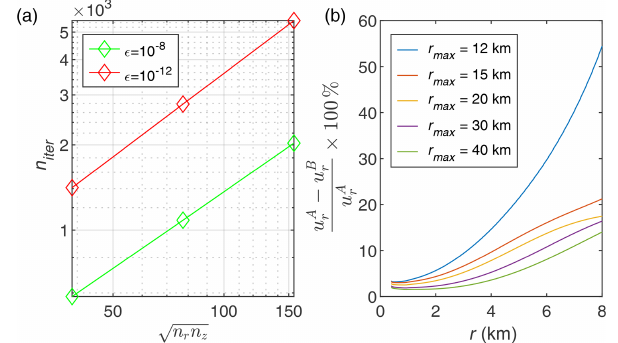
Figure 5. The simulation domain and the boundary conditions for the hydrodynamic simulation. The distribution of the gas saturation ( s g ) and the isotherms are shown at t = 120